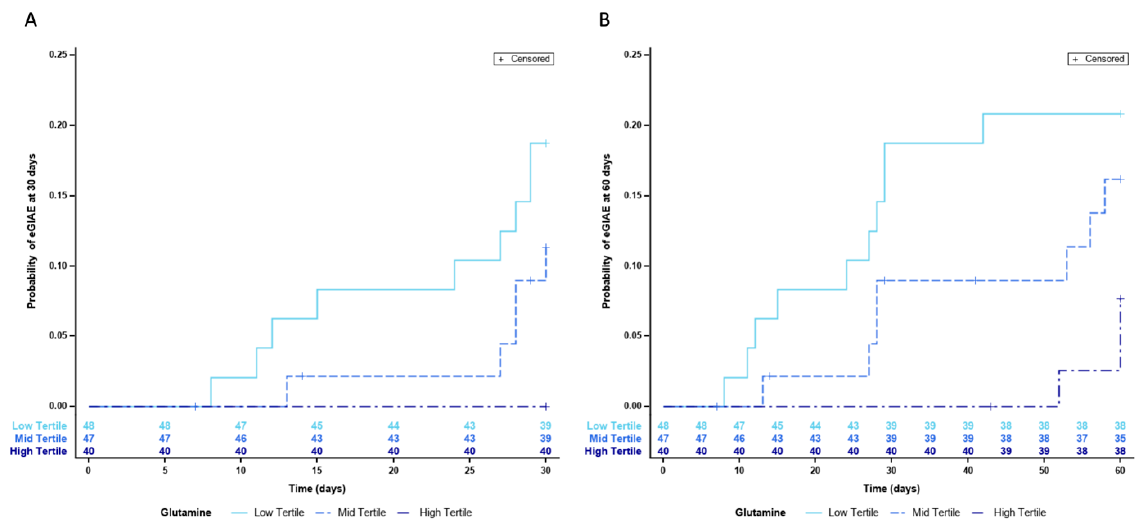
Figure 1. Risk of GIAE development according to blood L-Gln levels divided in terciles, ( A ) at 30 days and ( B ) at 60 days.